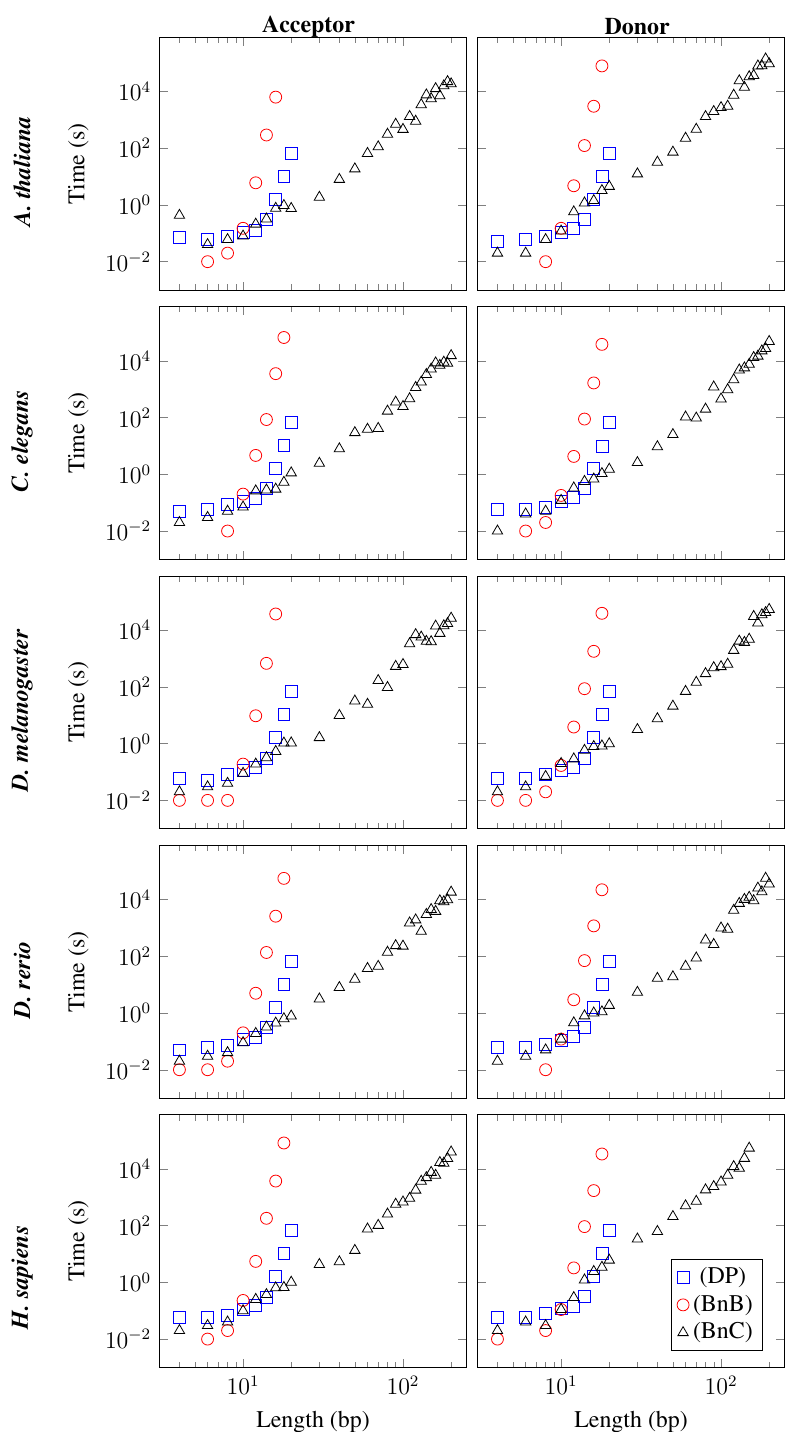
Figure 1. Running times of the three algorithms presented in Section 4 for five datasets of splice acceptor sites and five datasets of splice donor sites from A. thaliana , C. elegans , D. melanogaster , D. rerio , and H. sapiens of [22]. We plot the running time of each of the three algorithms as a function of the sequence length L ranging from 4 bp to 200 bp for each of the ten datasets provided the running time exceeds 10 − 2 s and does not exceed 1 . 5 × 10 5 s, corresponding to approximately two days. DP, dynamic programming; BnB, branch-and-bound; BnC,